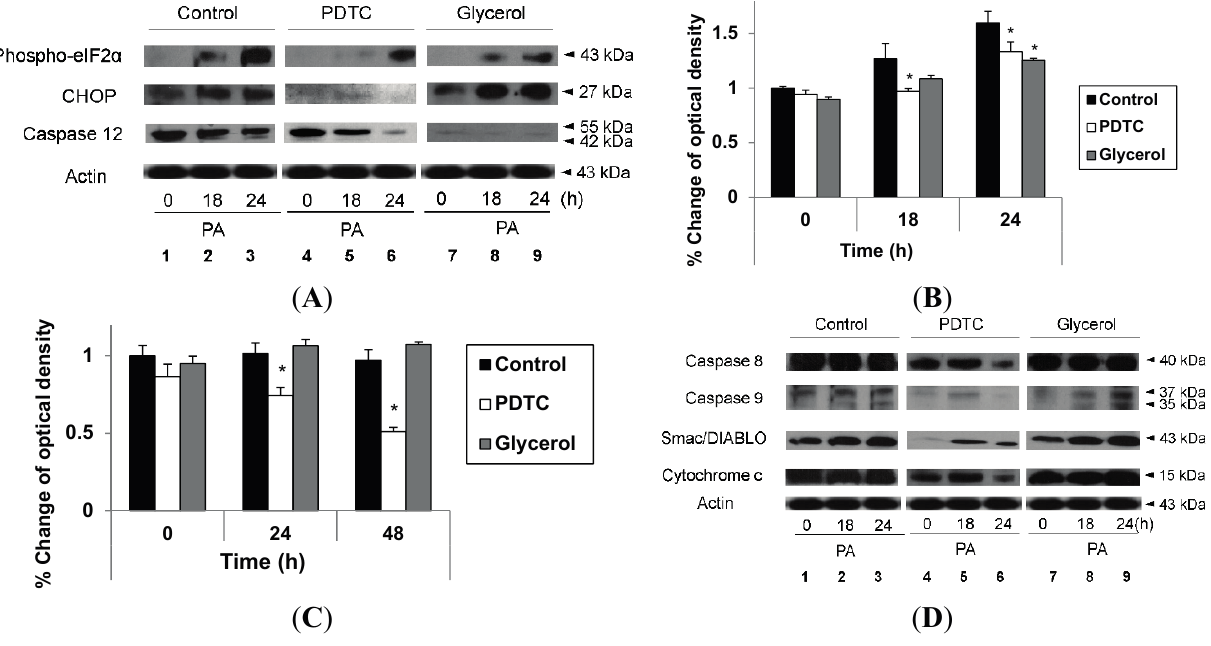
Figure 6. Attenuation of hypoxia-exacerbated ER stress by both PDTC and glycerol and attenuation of hypoxia-exacerbated lipoapoptosis by PDTC. HepG2 cells were cultured with PA (1 mM) under hypoxic culture conditions and were treated in three different manners for the indicated time periods: no treatment (control), PDTC (0.6 mM) and glycerol (1%). Immunoblot analysis was performed using anti-phospho-eIF2 α , anti-CHOP, anti-caspase 12 and anti-actin antibody ( A ); Densitometric evaluation was performed for anti-phospho-eIF2 α ( B ); and anti-CHOP ( C ); Immunoblot analysis was also performed using anti-caspase 8, anti-caspase 9, anti-Smac/DIABLO, anti-cytochrome c and anti-actin antibody ( D ). Data are expressed as the mean ± standard deviation of the percent change of optical densities compared to Time 0 h. * p <